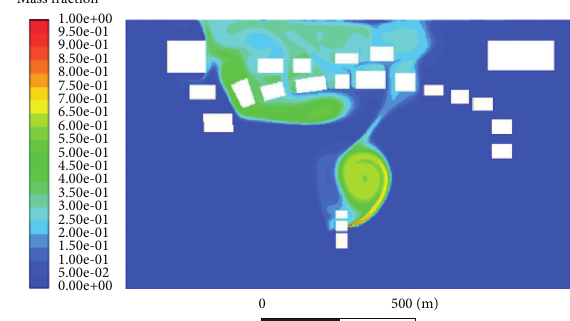
Figure 12: Radionuclide distribution rotating 180 ° clockwise at the southern break.